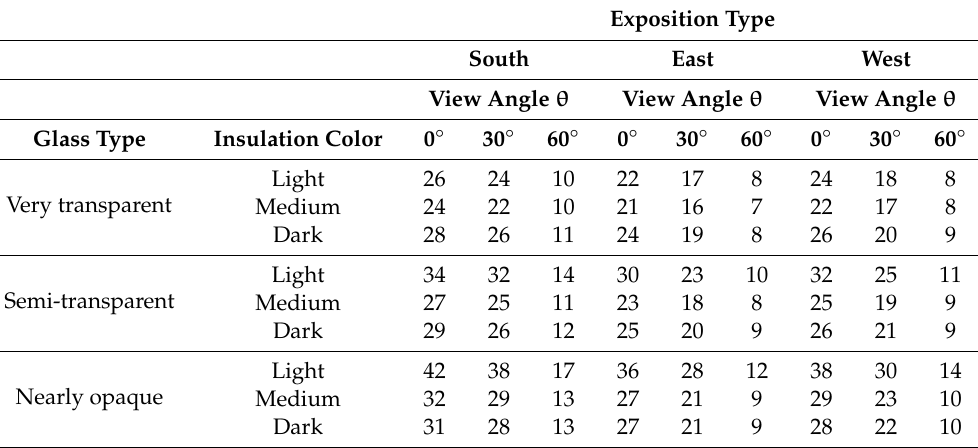
Table 10. Maximum thermal stresses (MPa) for